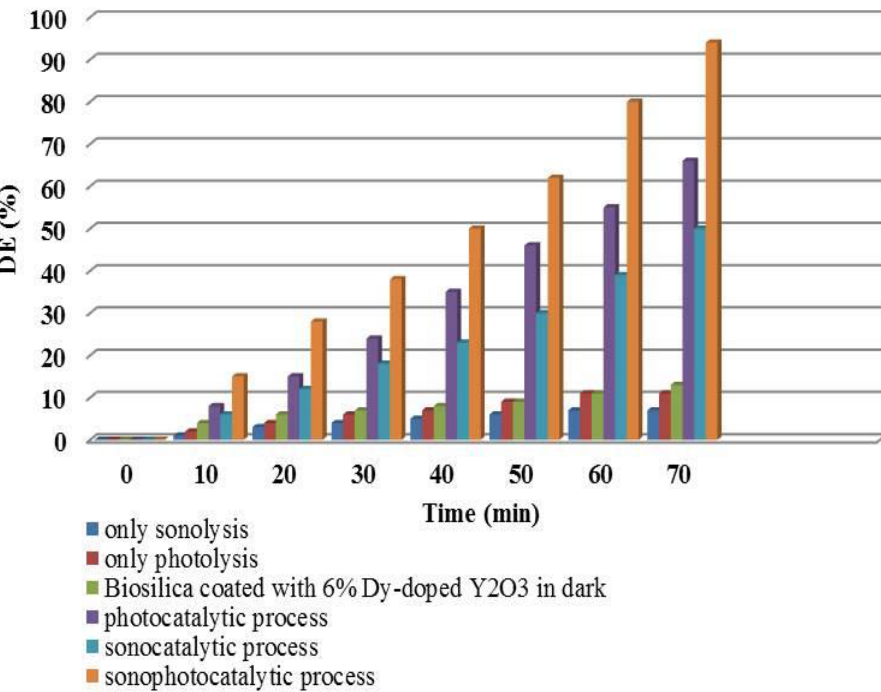
Figure 6. Comparison of different catalytic processes in decolorization of Reactive blue 19